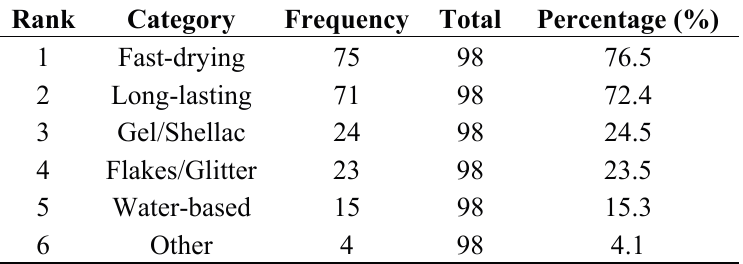
Table 2. Frequency table for nail polish category.